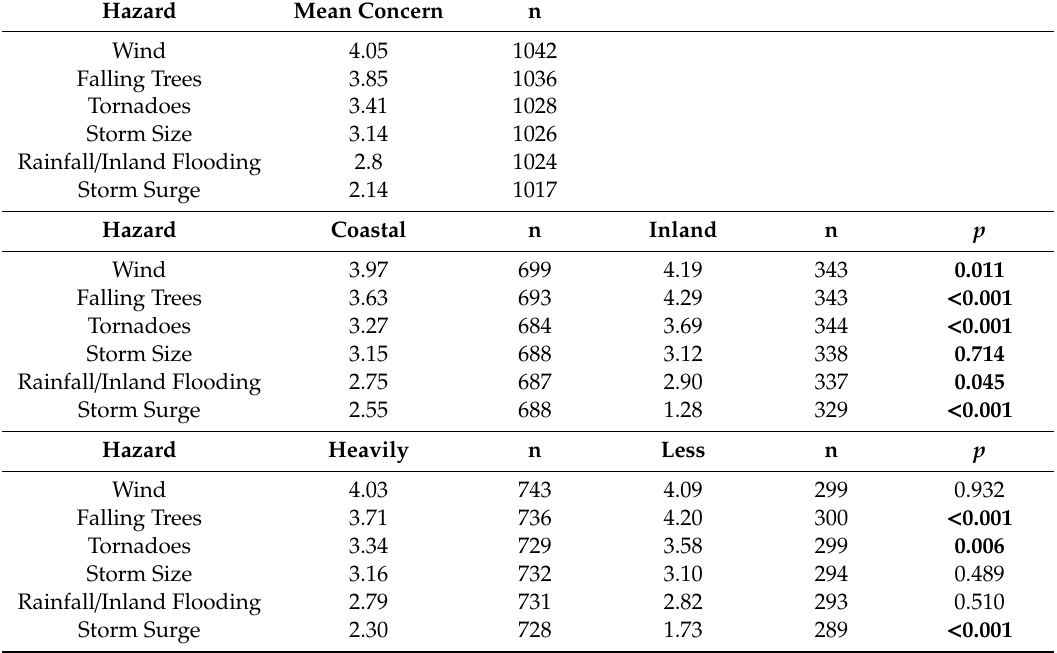
Table 4. (Top) Overall hazard concern and sample size ranked in descending order by greatest concern. (Middle) Hazard concern mean rankings, and statistical significance of Mann–Whitney tests comparing concern for participants from Coastal versus Inland counties. (Bottom) Same as middle but for Heavily Impacted versus Less Impacted counties. Bold indicates p <